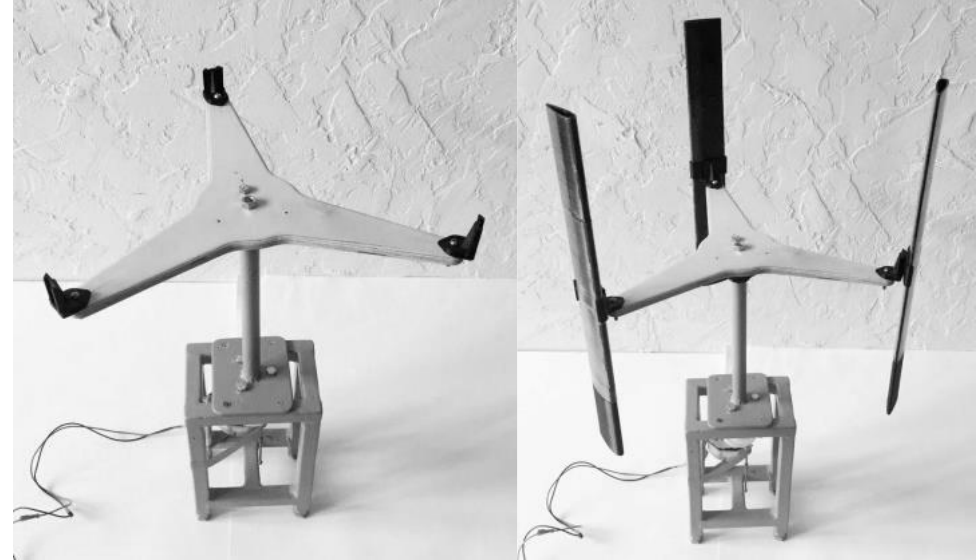
Figure 4. Experimental VAWT that allows changing different set of